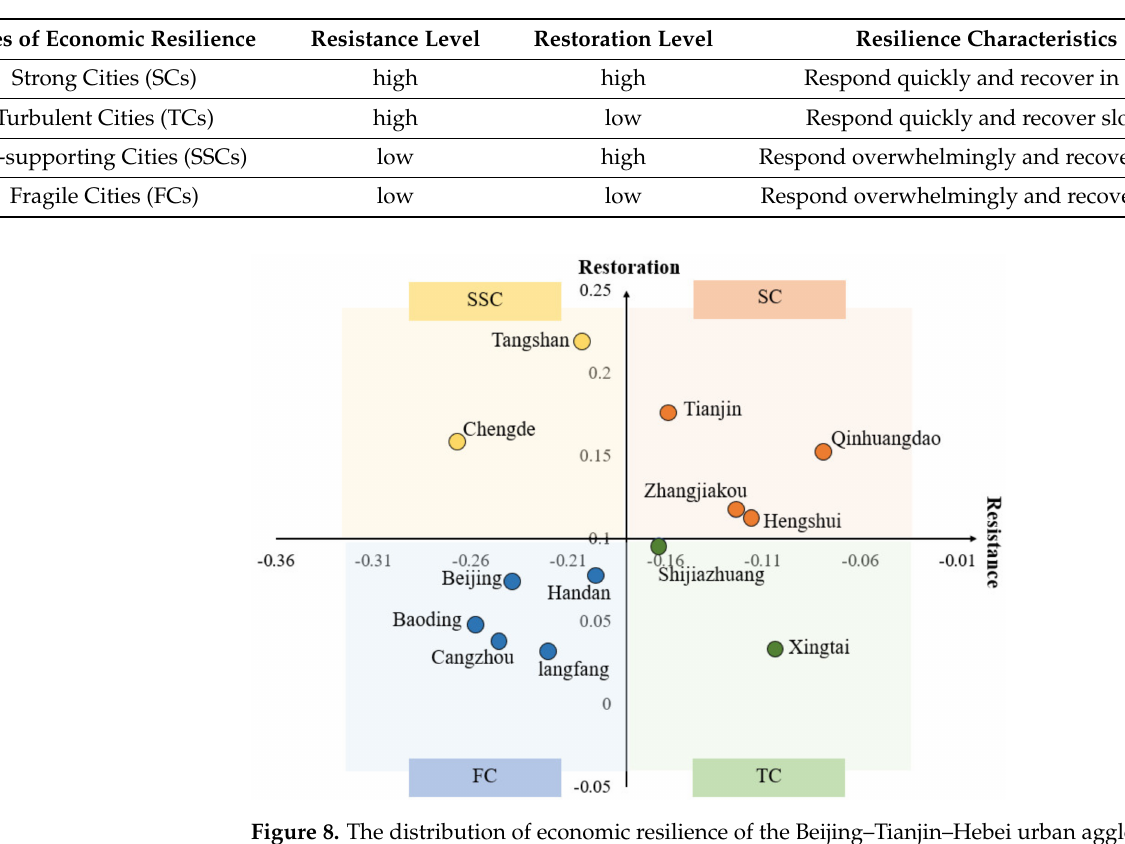
Table 3. Types of Economic Resilience.